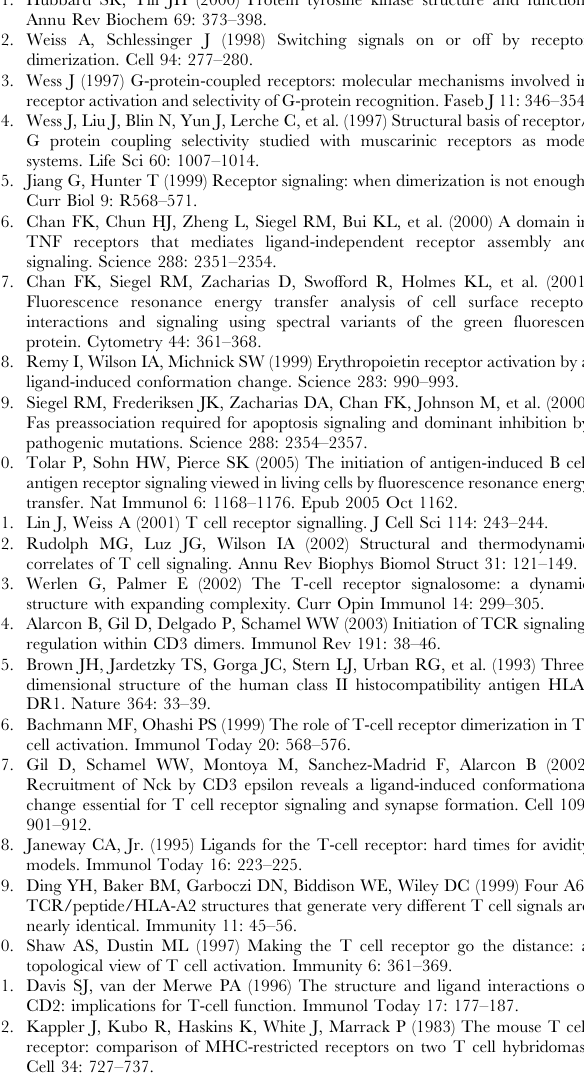
Supplemental Figure S2 Expected and observed sizes of partial trypsin digestion of the CD3zeta tail. A cartoon of the CD3epsilon and CD3zeta subunits showing potential trypsin cleavage sites (arrows). Transmembrane domains are indicated with grey boxes, and the relative positions of the three ITAMs are marked. The observed sizes of the partial digestion products were calculated from results shown in Fig.